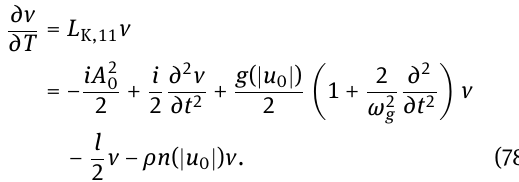
Fig. 3. The profile of the wake mode near t = 0 . The sharp spike Figure 3: The profile of the wake mode near t = 0 . The sharp spike in all curves around t = 0 corresponds to the location of the in all curves around t = 0 corresponds to the location of the modelocked pulse.